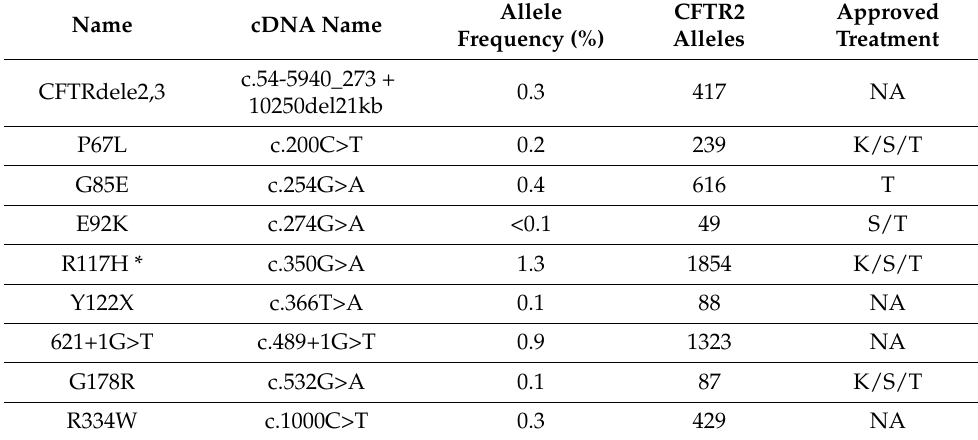
Table 1. Overview of CFTR mutations in this review, their frequency and approved